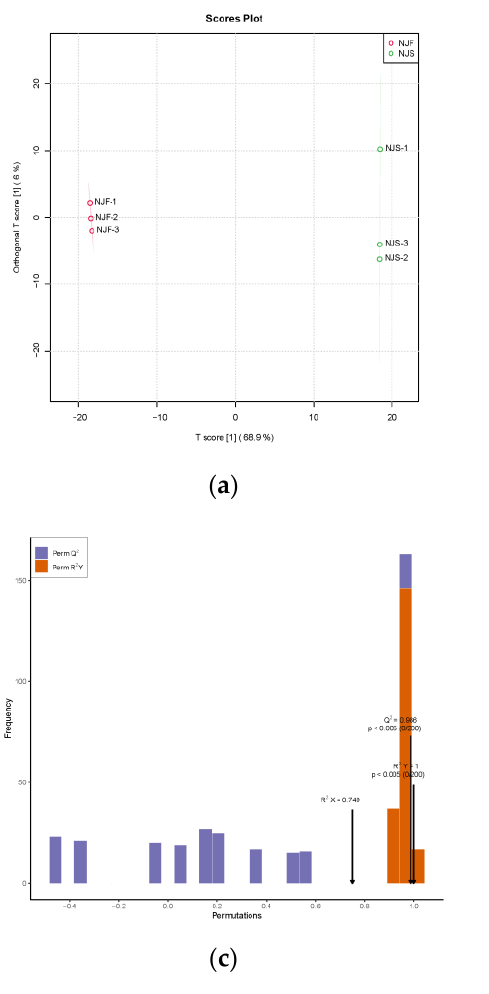
Figure 3. The metabolic variation between fresh and stored samples. ( a ) OPLS-DA score plot of different metabolites in NJS vs. NJF group. ( b ) OPLS-DA score plot of different metabolites in the JZS vs. JZF group. ( c ) Permutation testing of OPLS-DA in NJS vs. NJF group. ( d ) Permutation testing of OPLS-DA in JZS vs. JZF group.